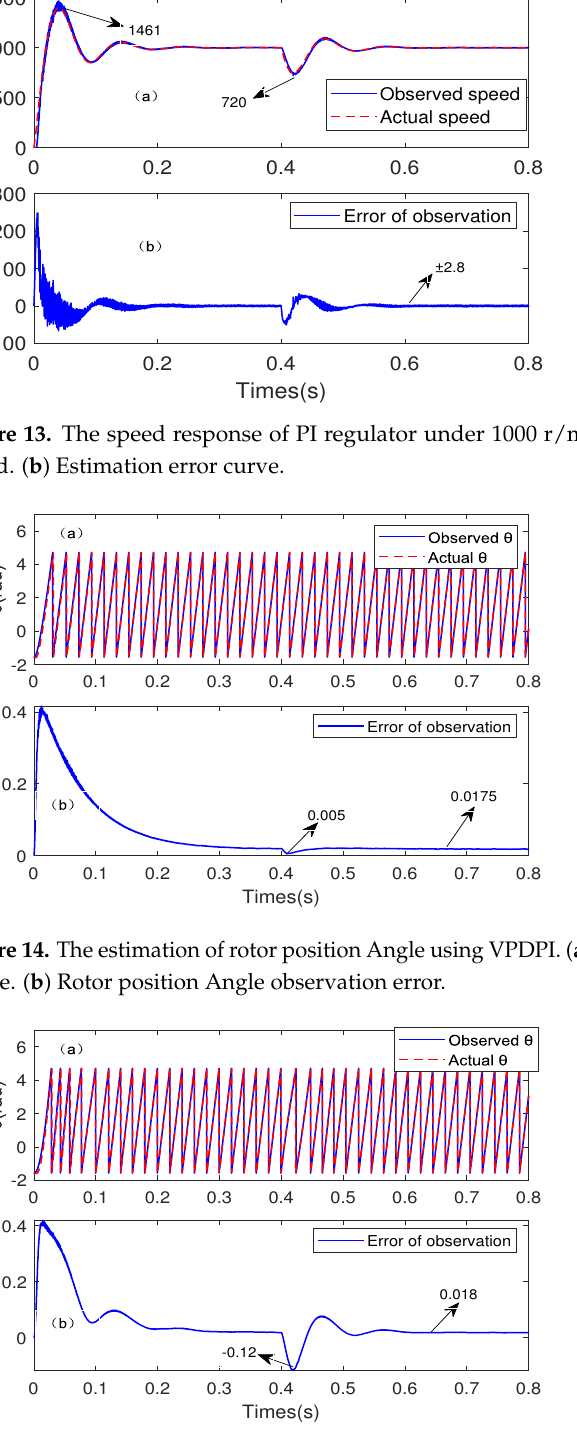
Figure 15. The estimation of rotor position Angle using PI. ( a ) Observed and actual rotor position Angle. ( b ) Rotor position Angle observation